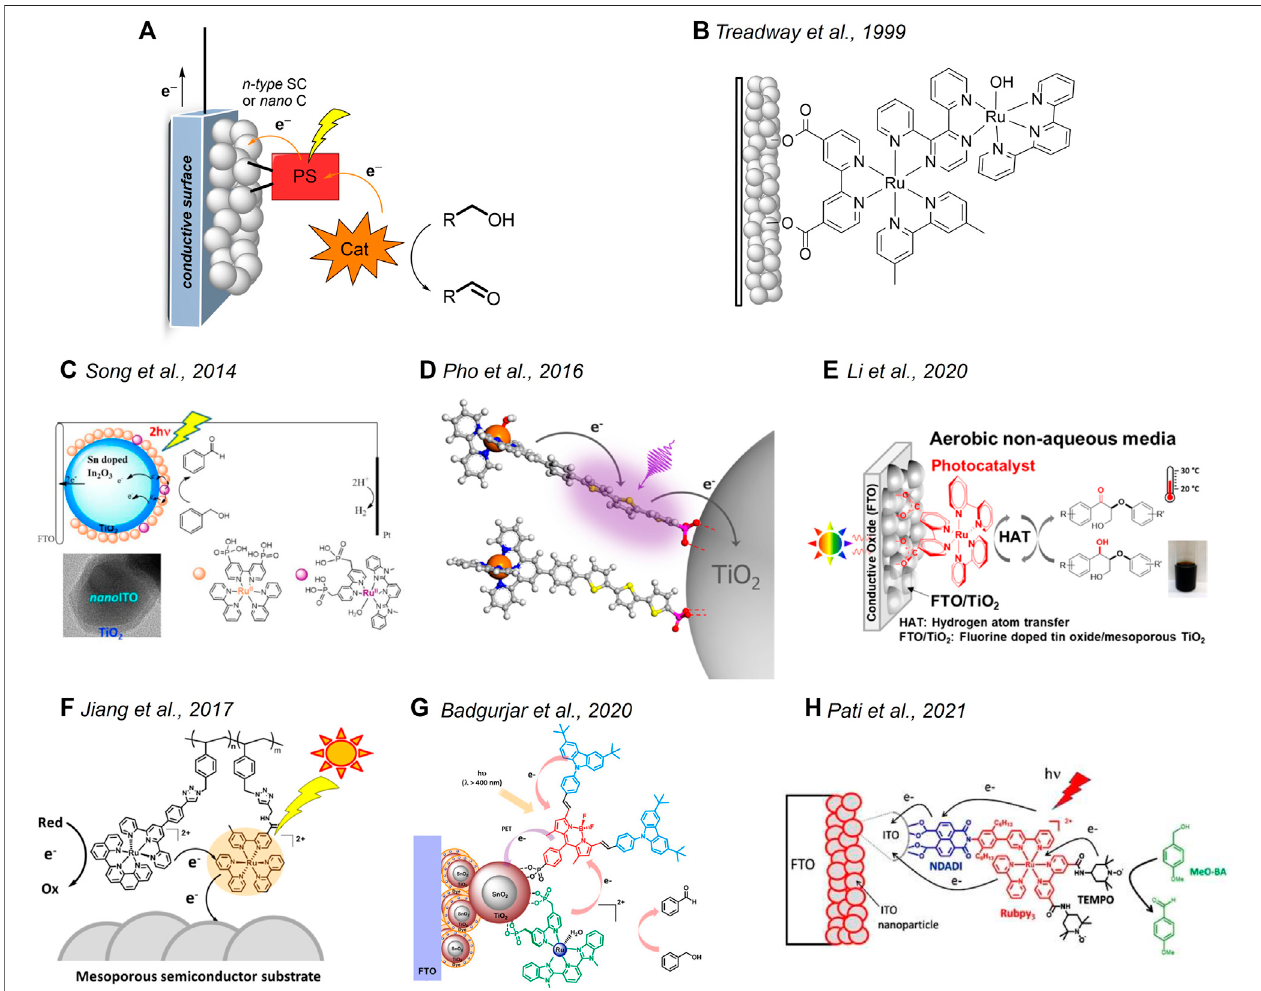
FIGURE 1 | (A) Main components of a hybrid photoanode for alcohol oxidations and related light-driven processes (legend: SC = semiconductor, C = conductor, PS=photosensitizer,Cat=catalyst). (B – H) HybridsystemsbasedonRu-derivativesdiscussedin SystemsBasedonRutheniumComplexessection . (C) Reprintedwith permission from Song et al. (2014). Copyright 2014 American Chemical Society. (D) Reprinted with permission from Pho et al. (2016). Copyright 2016 American Chemical Society. (E) Reprinted with permission from Li et al. (2020). Copyright 2020 American Chemical Society. (F) Reprinted with permission from Jiang et